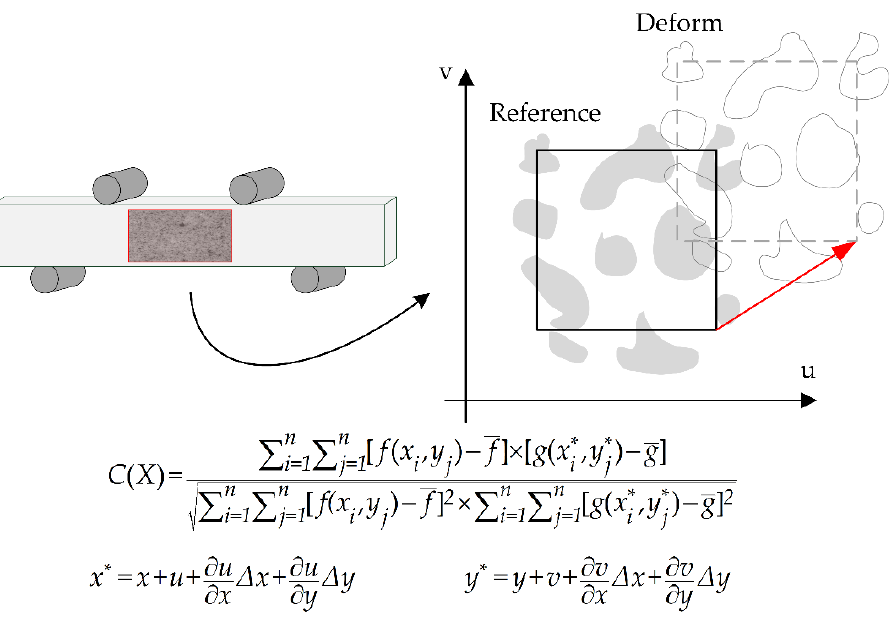
Figure 5. The schematic diagram of the DIC method. For the reference image, f ( x , y ) is the gray value of the coordinate ( x , y ). For the target image, g ( x* , y* ) is the gray level value of the coordinate ( x* , y* ). f and g are the average gray values of each image. The image at a stress value of 0 MPa before cyclic loading was used as the reference image. The images at a stress value of 66 MPa at different life fractions were used as the deformed images. After acquiring the images, the displacement fields in the DIC calculation areas were computed by tracing the gray level value of each point in the reference and deformed images as well as performing their image correlation. The correlation coefficient is defined as